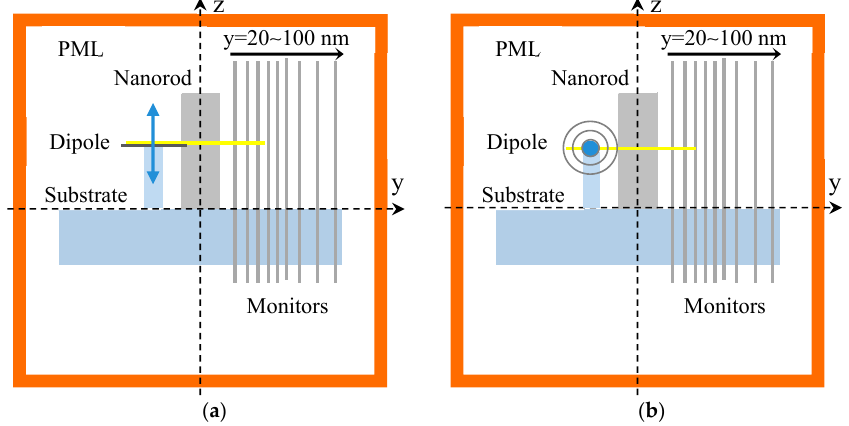
Figure 9. Schematic illustration of the FDTD simulation domain of the plasmonic nanorod on a SiO 2 substrate. The incident light waves were two broadband electric dipole sources with the different polarization directions along the z- ( a ) and x- ( b ), respectively. The boundary conditions were PML in the x-, y-, and z-directions. Both x and y span ranges were − 15 nm to 15 nm and the z-span range of the nanorod was 0 nm to 100 nm, and the z-span range of the substrate was − 100 nm to 0 nm. The simulation geometry had a mesh accuracy of 7. The different power monitors with the 2D y-normal type (x–z plane) were selected to analyze the electric field distributions in di ff erent near field regions, and the y-normal monitor that collects the electric field in x–z plane were put onto the di ff erent positions with di ff erent y-values of 20, 30, 35, 40, 45, 50, 60, 80, and 100